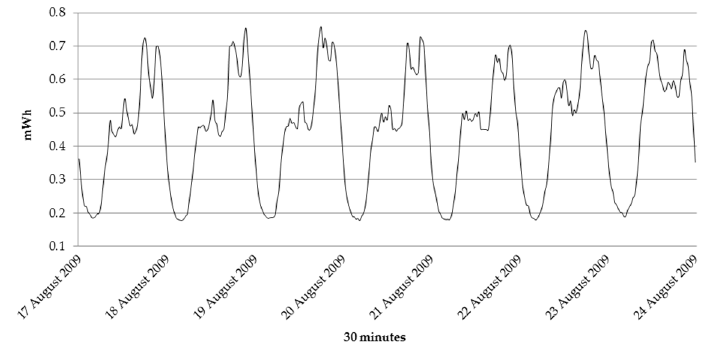
Figure 4. Daily dynamics of the 30-min load data observed between 17 August (Monday) and 24 August (Sunday) 2009.